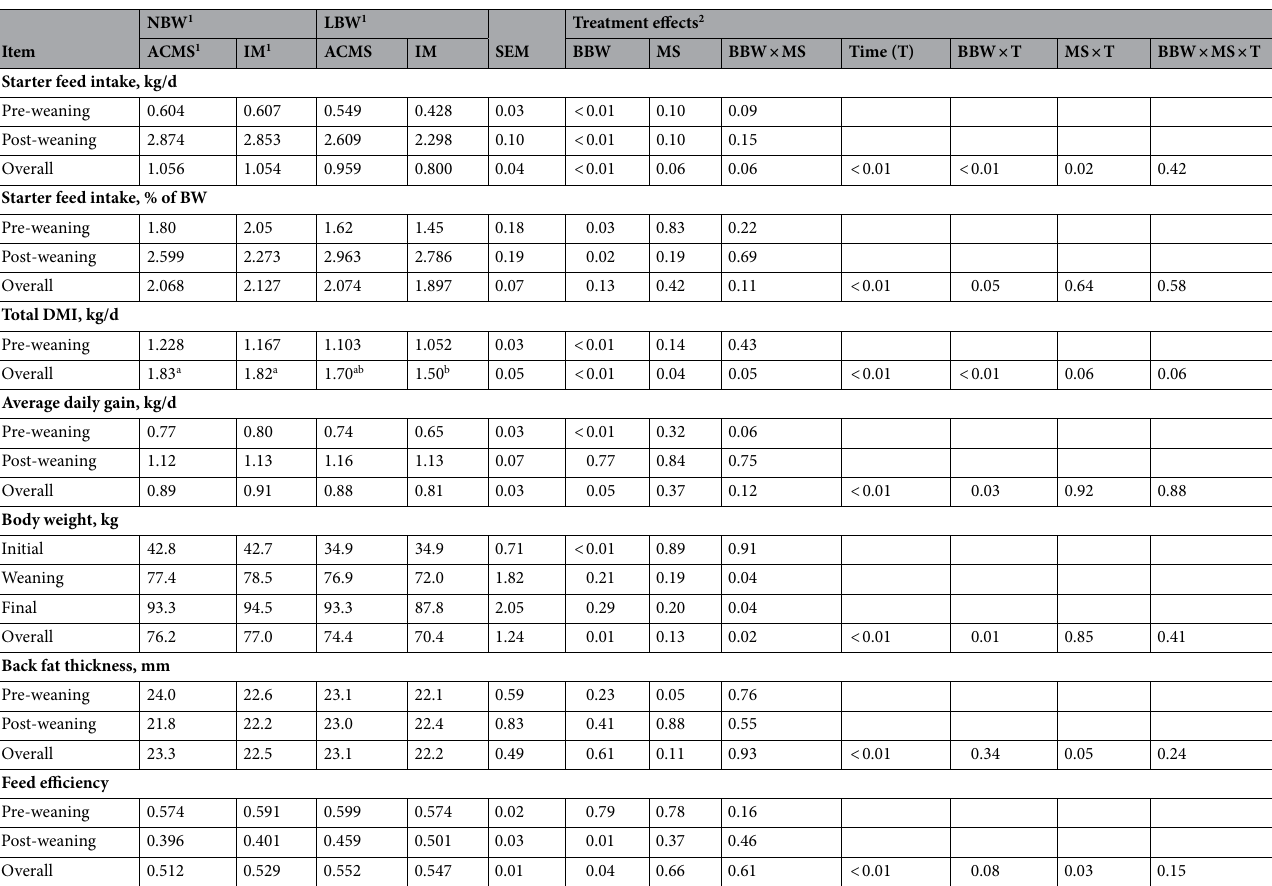
Table 4. Effects of dietary mineral source and birth body weight (BBW) on dry matter intake (DMI), average daily gain, body weight, back fat thickness, and feed efficiency of dairy calves (n = 13 per treatment). 1